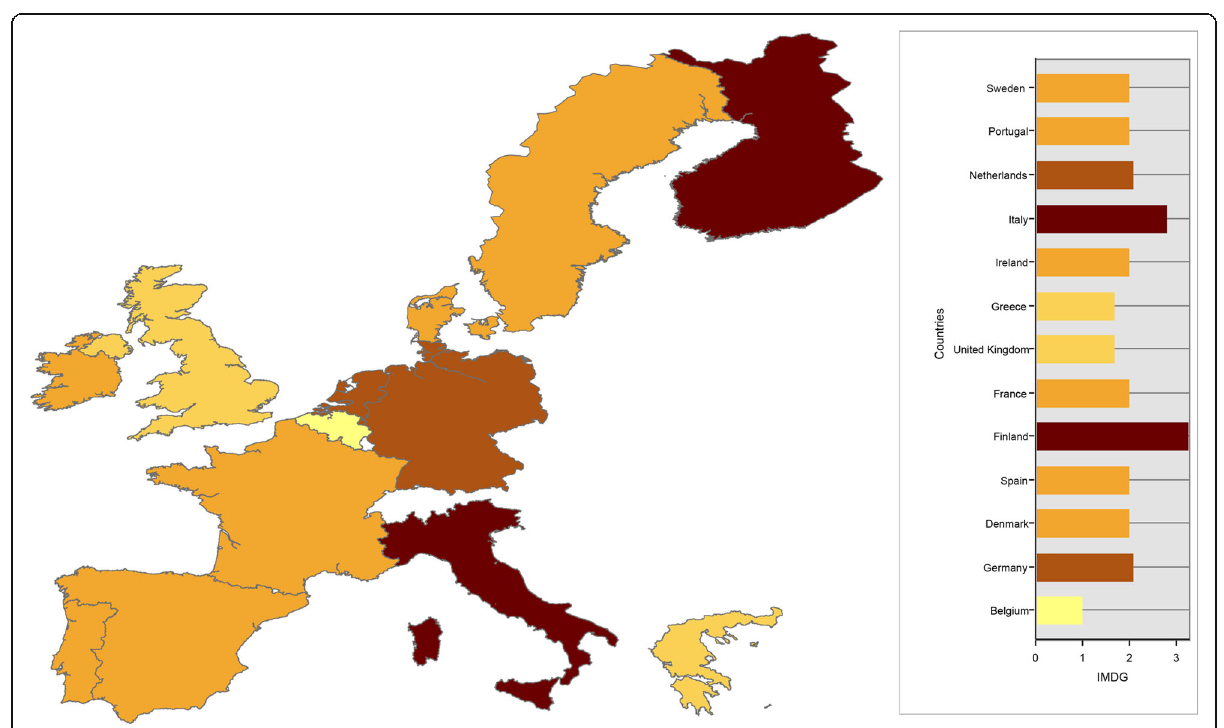
Fig. 9 The weighting of Dangerous Goods deficiencies as a result of AHP